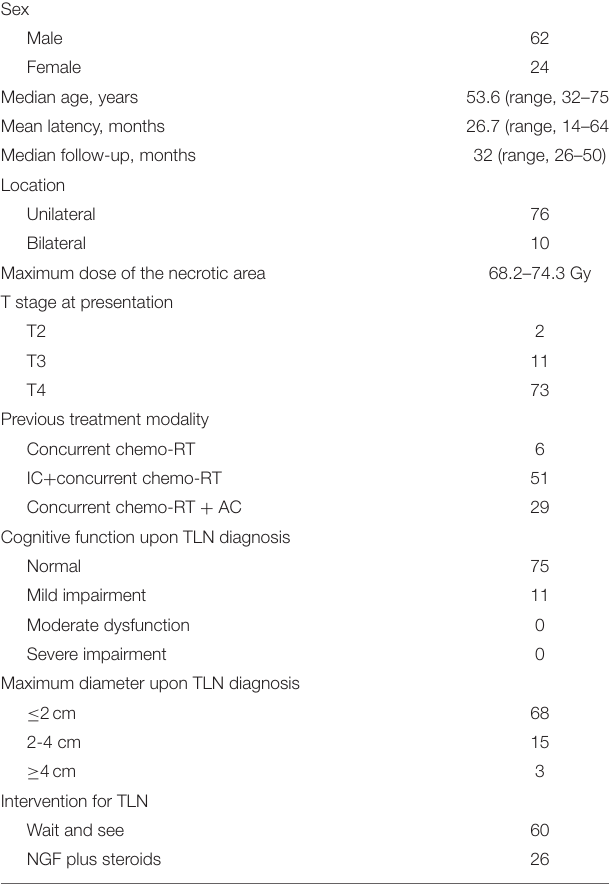
TABLE 1 | Characteristics of the 86 enrolled patients with